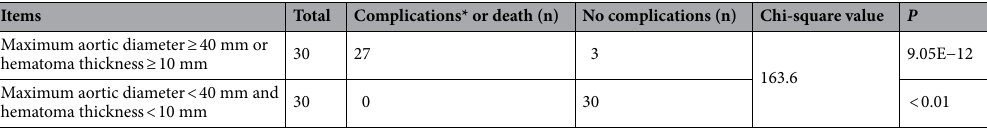
Table 7. Comparison of the maximum aortic diameter and hematoma thickness for the conservative treatment of Stanford B IMH. *Progression of aortic dissection, pseudoaneurysm, rupture, visceral arterial perfusion, lower limb ischemia.